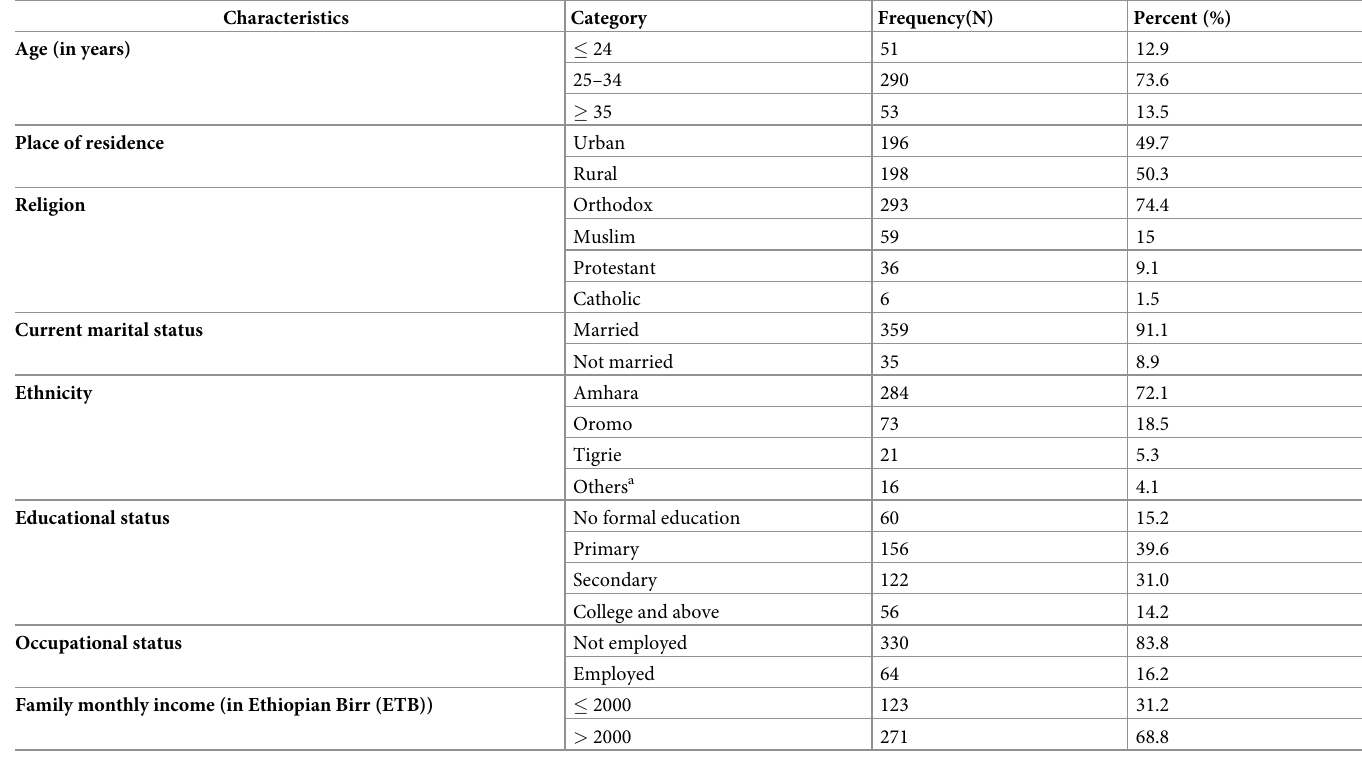
Table 1. Socio-demographic characteristics among postpartum women at public hospitals of North Shoa Zone Ethiopia (n =